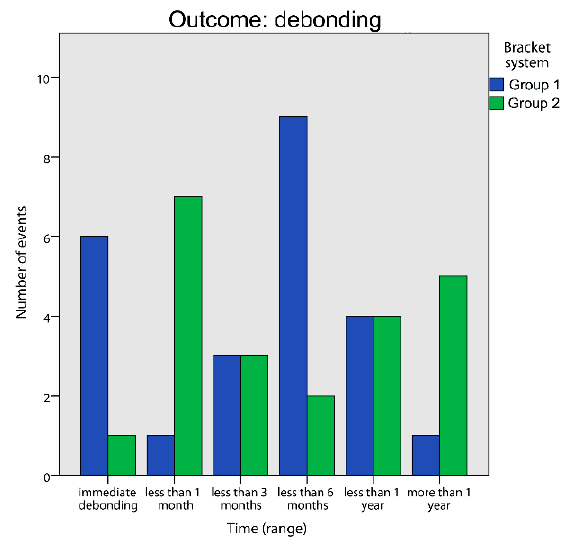
Figure 1. Frequency of debondings over time for Group 1 and Group 2.